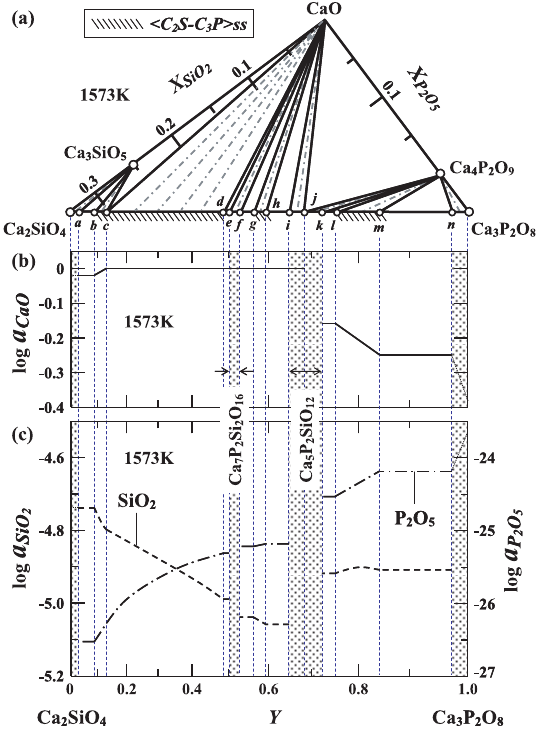
Fig. 4: (a) Iso-thermal section of the ternary system CaO-SiO 2 -P 2 O 5 near the CaO apex at 1573 K. (b) Activities of CaO at 1573